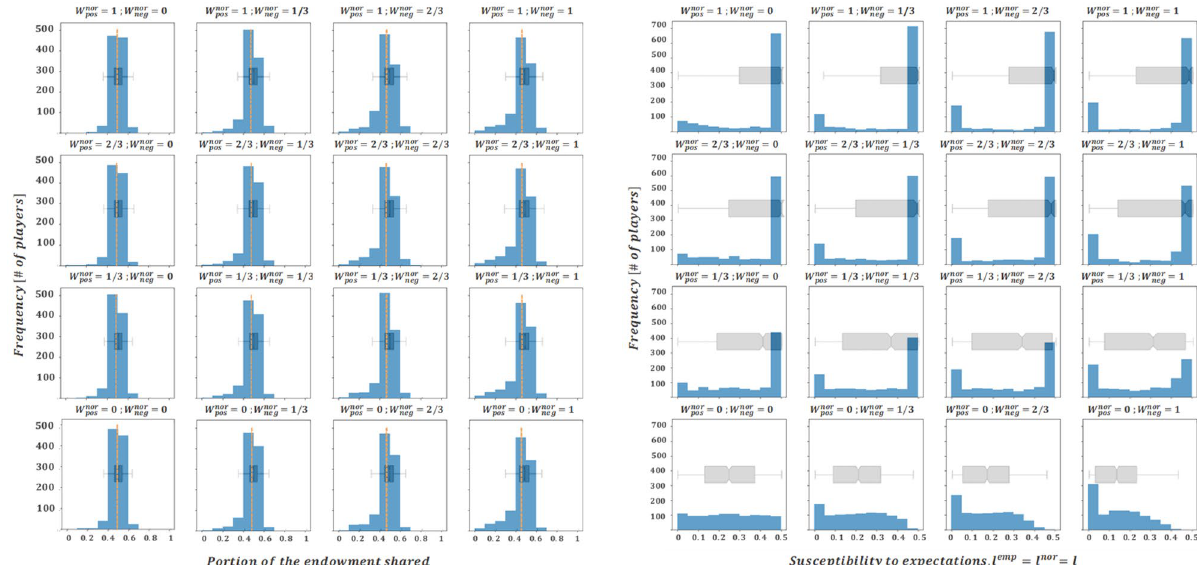
Figure 2. Final averaged distributions of donations (left) and susceptibility profiles with = l emp W emp = 0 . Each subplot represents results for the scenarios of l nor i , t (right) for i , t W nor , pos ( whichvariesacrossrows ) and W nor , neg ( whichvariesacrosscolumns ) assumed in B )